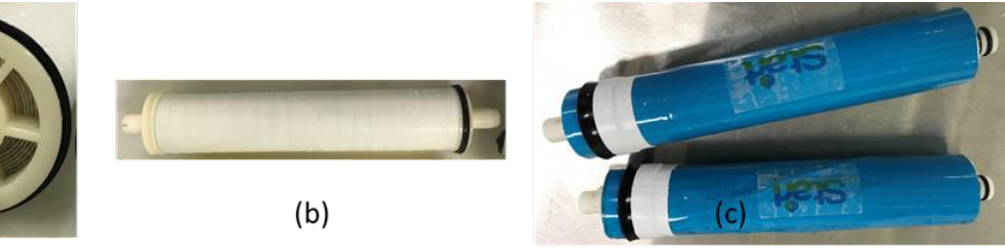
Figure 3. Examples of the 2514 ( a , b ) and 1812 ( c ) SWM elements that were assembled using the reinforced membranes coated with PA TFC layer.